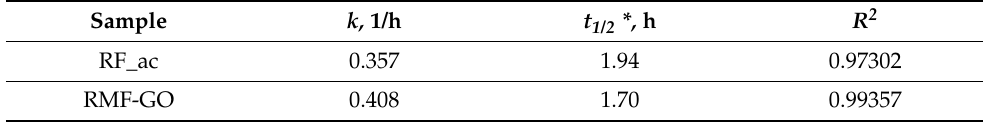
Table 6. Kinetics of the